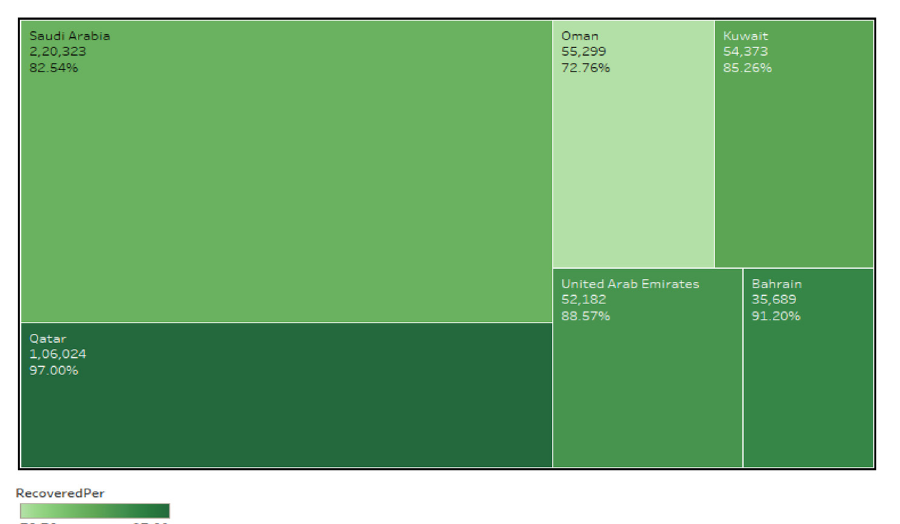
Figure 5. Deaths and death rate